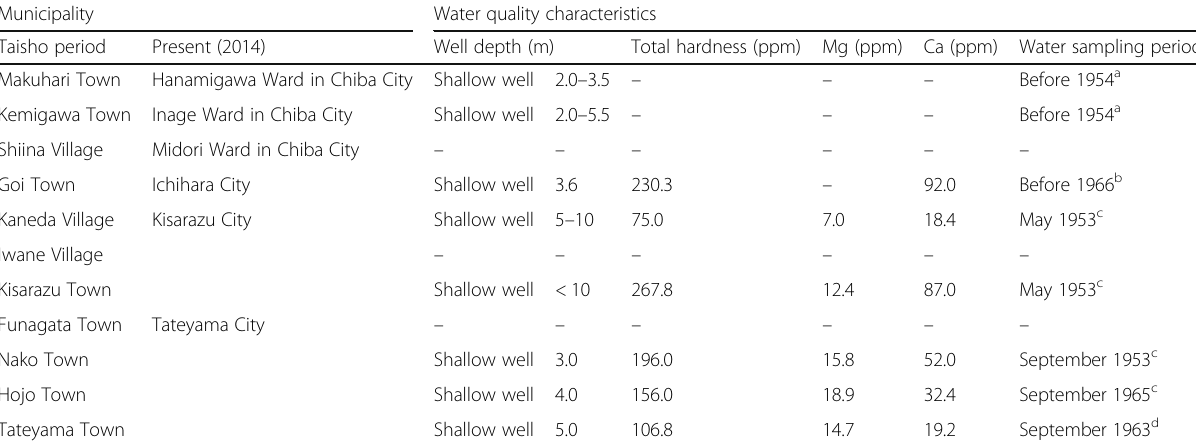
Table 2 Study sites ’ water quality Municipality Water quality